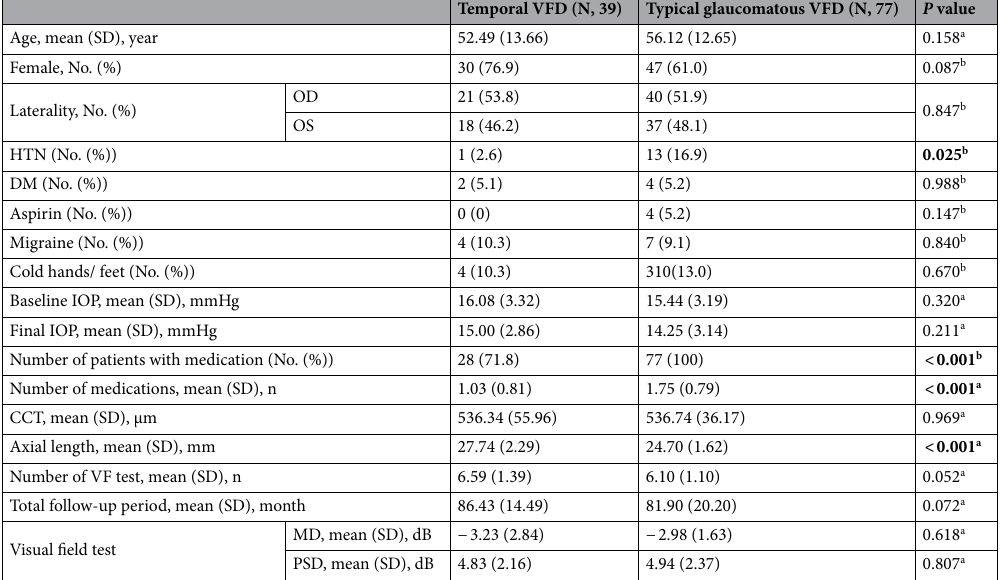
Table 1. Patients demographics (Total 116 eyes). VFD visual field defect, HTN hypertension, DM diabetes mellitus, IOP intraocular pressure, n number, CCT central corneal thickness, VF visual field, MD mean deviation, PSD pattern standard deviation, dB decibel. Mean values are presented with standard deviations a Student’s t-test after Propensity score match, b chi-squared test. Bold font indicates significant P values ( P <